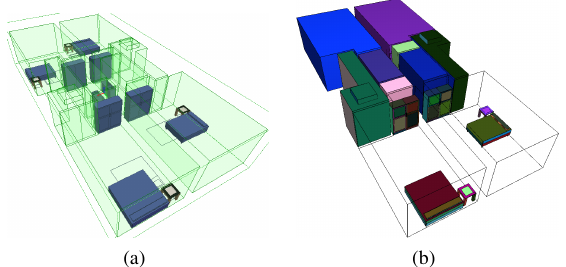
Figure 2: IfcSpace that includes the furnitures. (a) Original IFC model. (b) Corresponding FS-LCC (with two IfcSpaces rendered in wireframe).